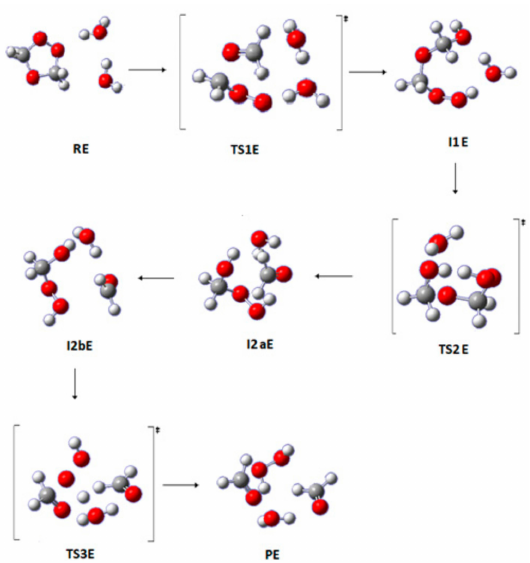
Figure 6. Optimized geometries for the stationary points in Pathway E of the reaction between SOZ and 2H 2 O. Calculated at the APFD / 6-311 ++ G(3df,3pd).